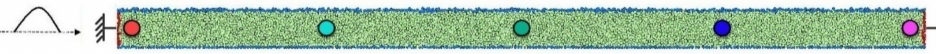
Figure 3. Setting the left and right boundaries as fixed boundaries.